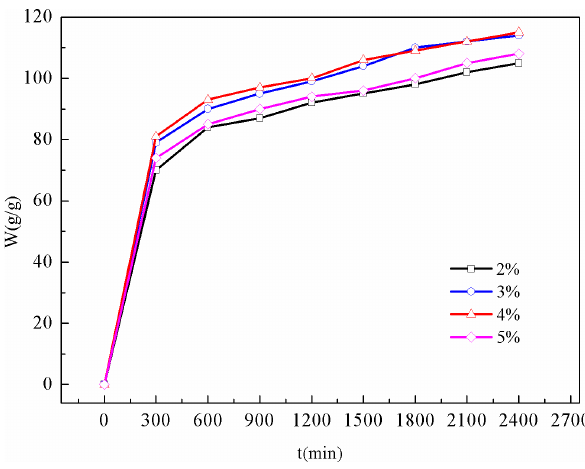
Figure 2: The deionized water absorption of foam gel at different SDS concentrations